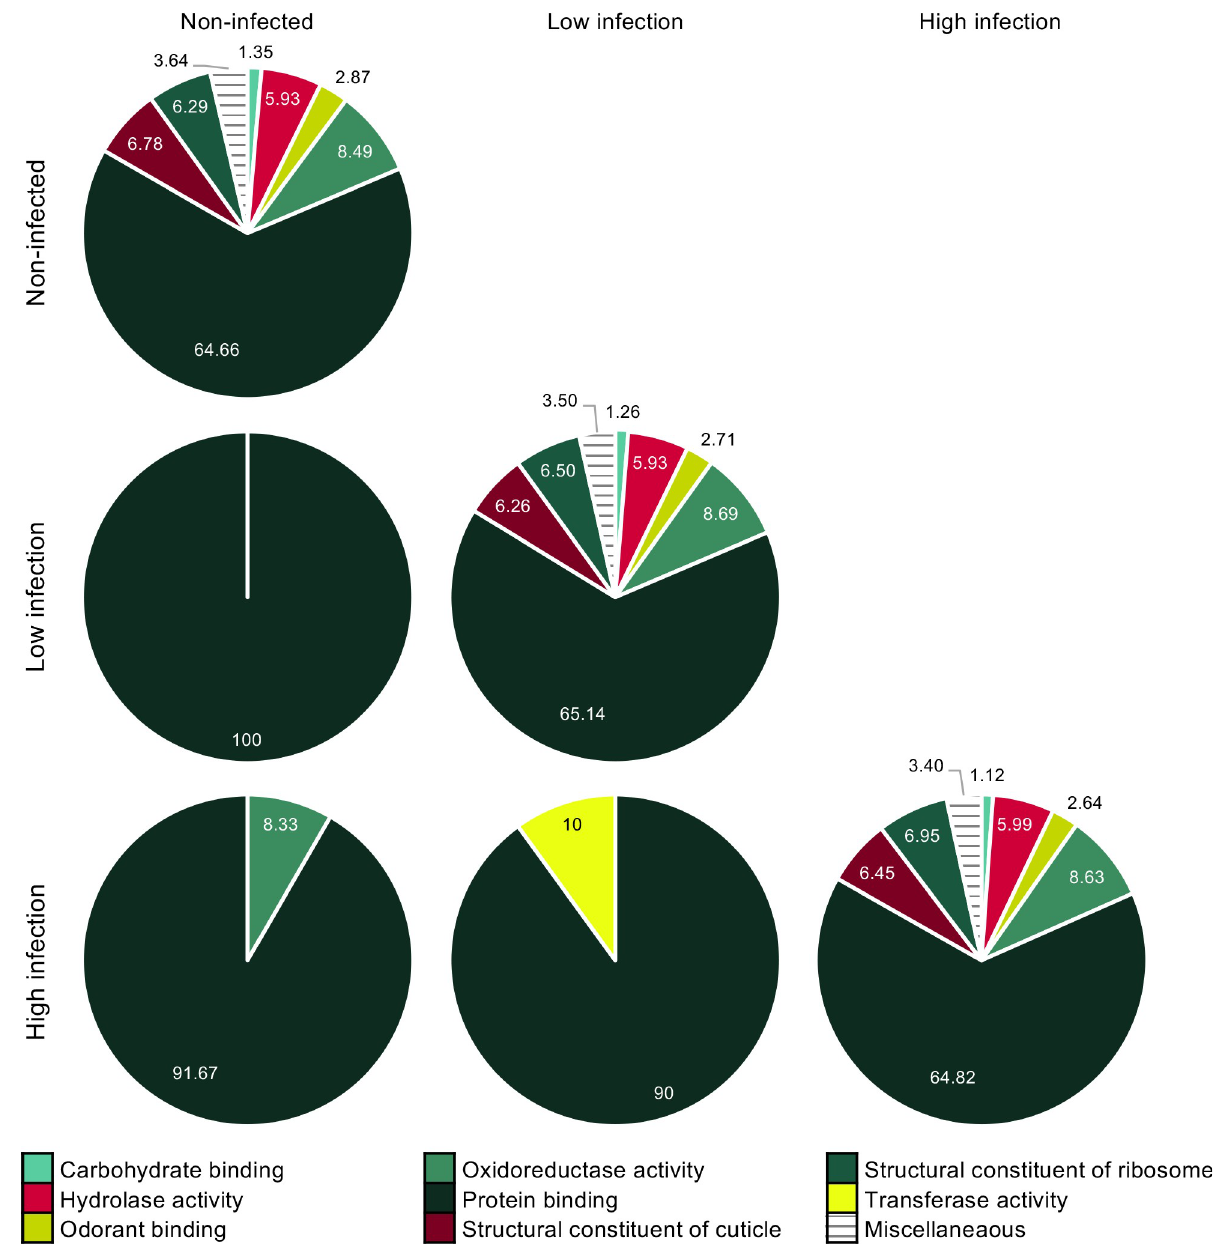
Fig 4. Dengue infection induces differential transcript abundances described by a level three gene ontology analysis of molecular function in the antennal tissue. A ) The proportion of reliably detected transcripts (n = 16,550) in the antennal transcriptomes of non-infected, low and highly infected females (DENV-1 infection at 14 days post-infection) are presented. B ) The proportion of differentially abundant transcripts (n = 402) among pairwise comparisons of the three conditions are presented in a